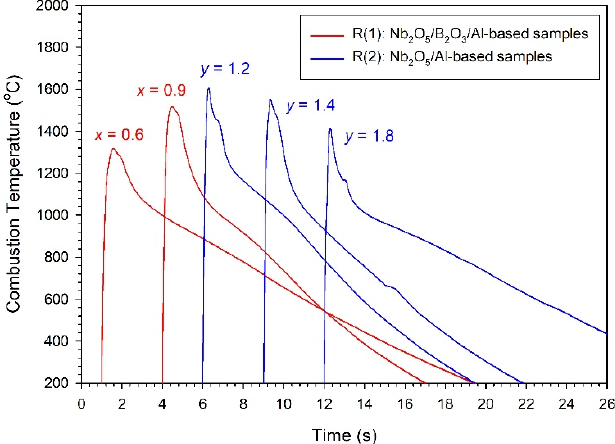
Figure 3. Combustion temperature profiles measured from samples of Reactions (1) and (2) with different stoichiometric coefficients.